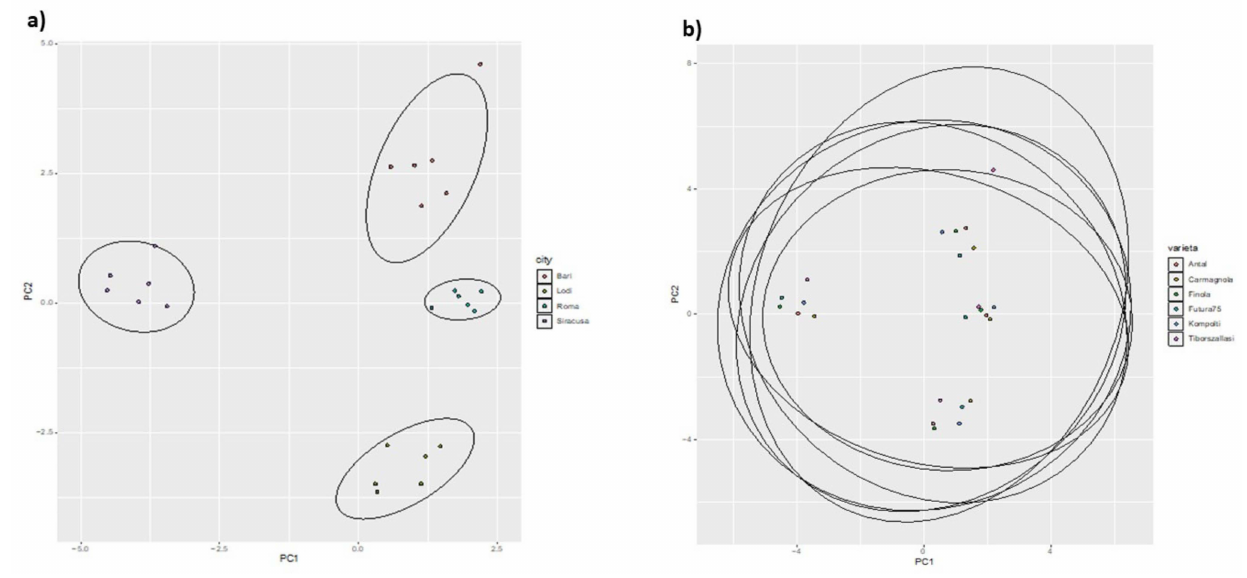
Figure 6. Score plots of the investigated Italian hemps. Drawn ellipses suggest the clustering of samples according to the geographical origin ( a ) botanical variety ( b